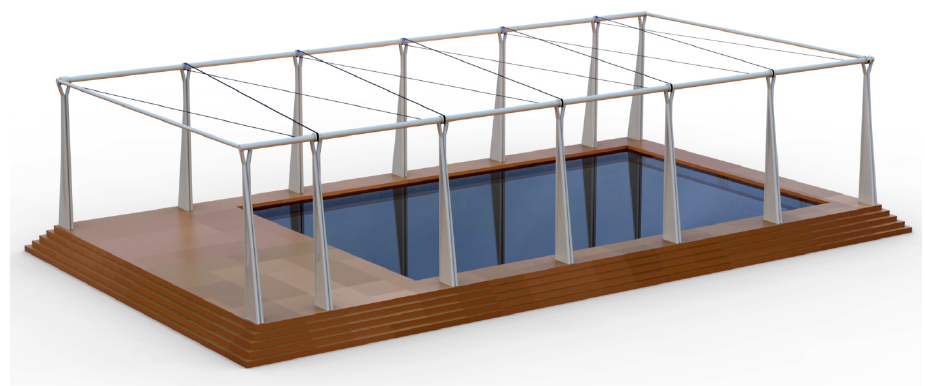
Figure 31. Swimming pool cable roof with CFRP Continuous Band Winding System.